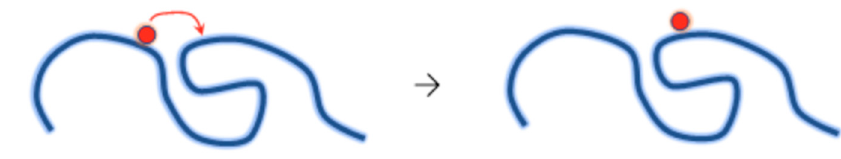
Figure 17. H-transfer leading to a shift in location of the radical along a polymer chain.